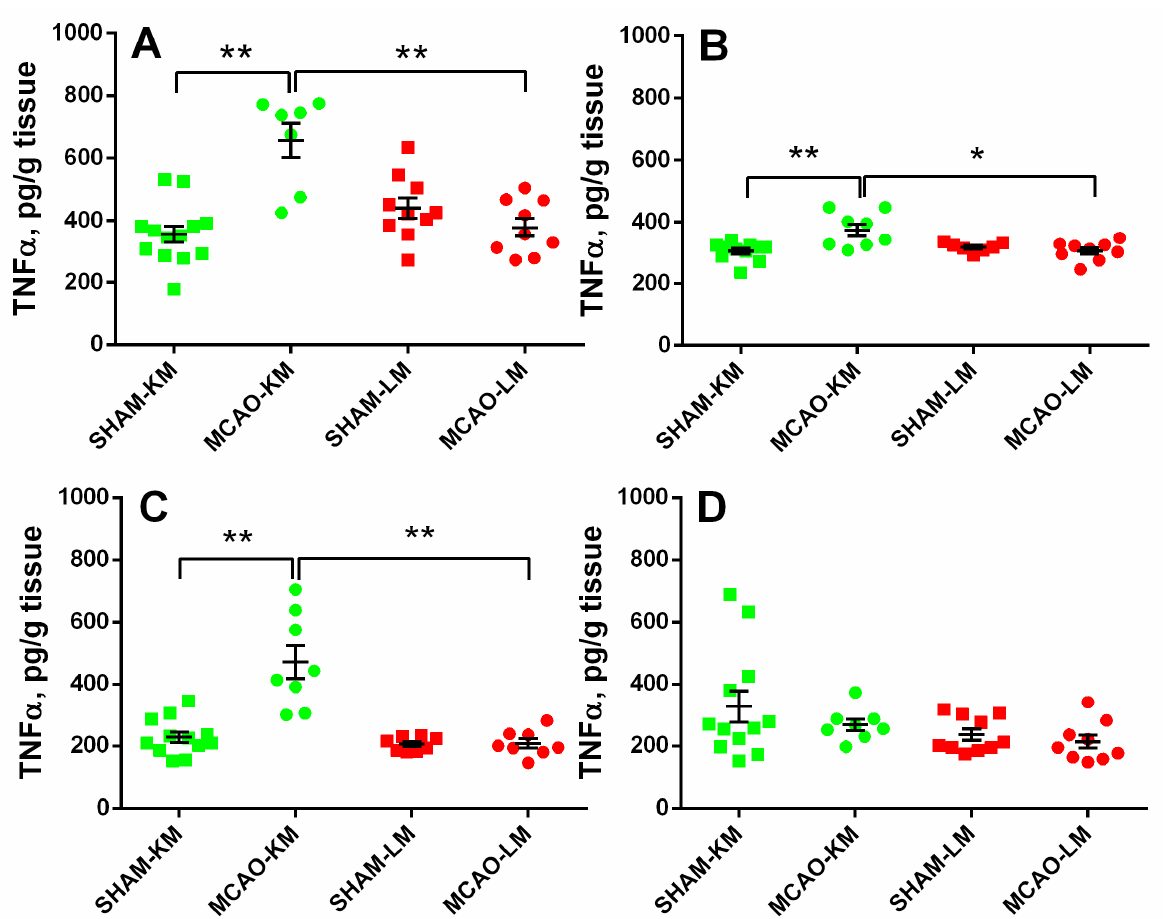
Figure 5. TNF α levels in the hippocampus ( A , B ) and FC ( C , D ) of MCAO-KM and MCAO-LM groups 3 months after surgery. ( A ) Ipsilateral hippocampus. ( B ) Contralateral hippocampus. ( C ) Ipsilateral FC. ( D ) Contralateral FC. ( A – D ) TNF α , pg/g tissue. ** p < 0.01 and * p < 0.05 compared with the respective sham-operated groups or MCAO-KM and MCAO-LM.